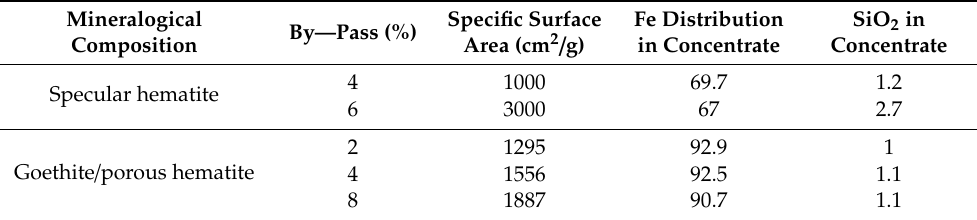
Table 2. E ff ect of the specific surface area on the flotation behavior of iron ores presenting di ff erent mineralogical compositions [6].